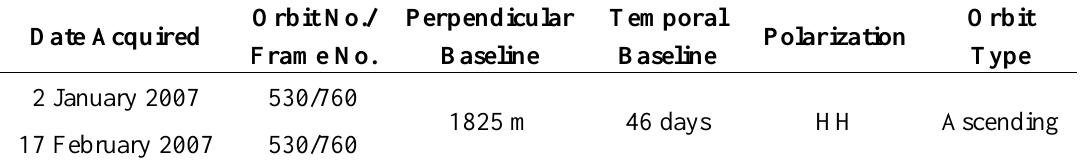
Table 2. ALOS/PALSAR image pairs used in pixel-tracking